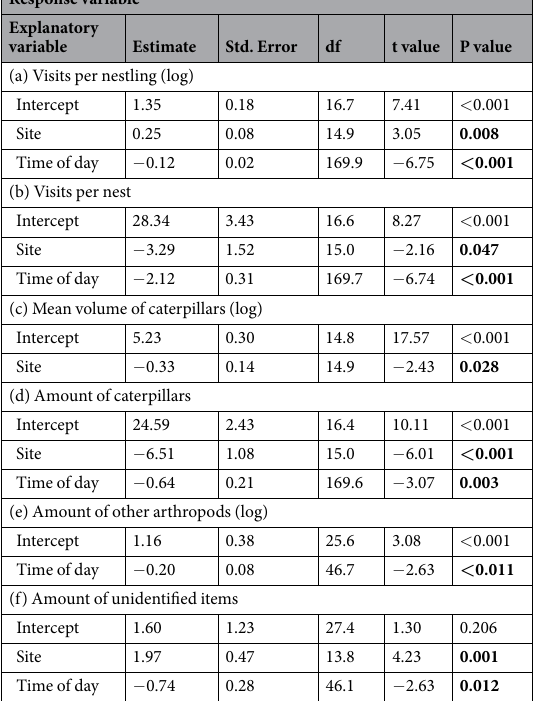
Table 5. Results from LMMs investigating how provisioning rates and dietary sources fed to nestlings varied across the three study sites. In all models, site, time of day and date were included as fixed effects, and dropped if not significant via backward selection (only significant variables are shown). Nest-box (brood) was included as random factor. We indicate in brackets whether the response variable was